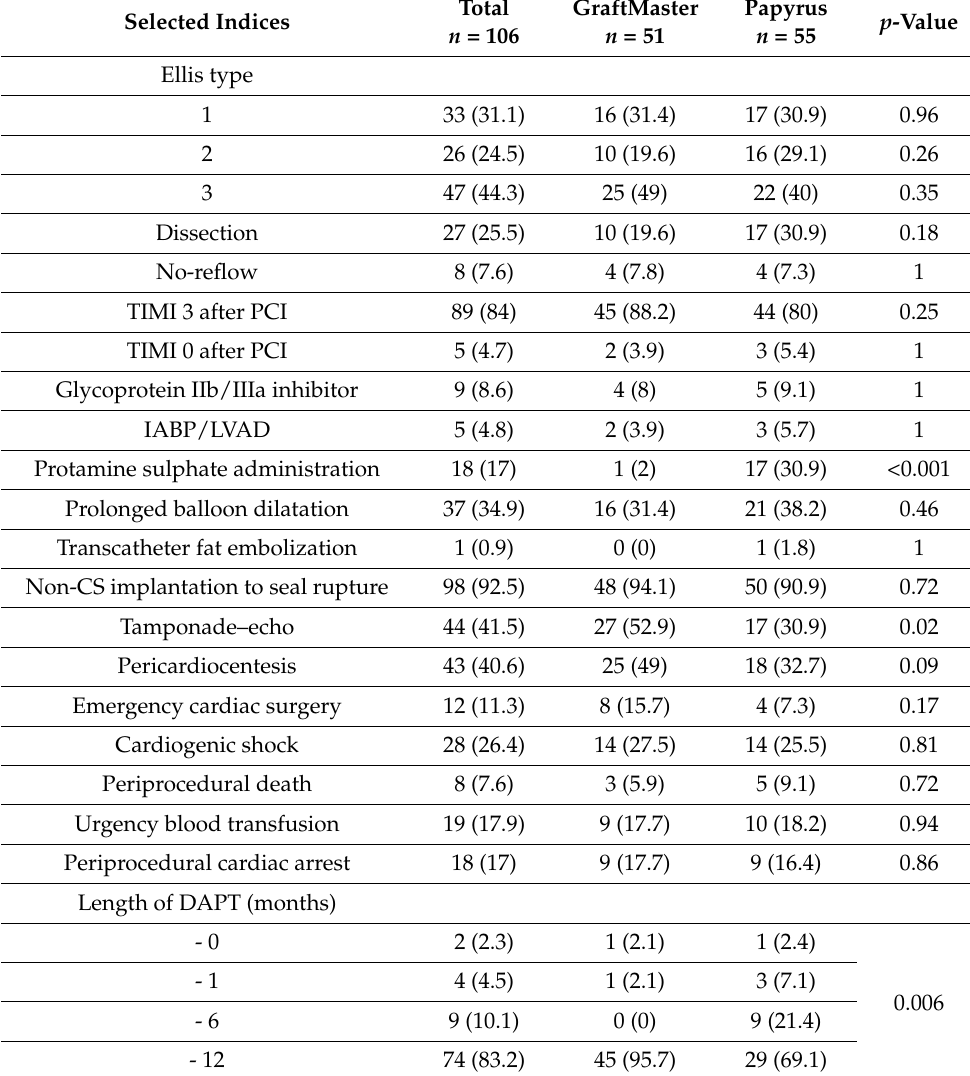
Table 3. Characterisation of coronary artery perforation, periprocedural complications, and their